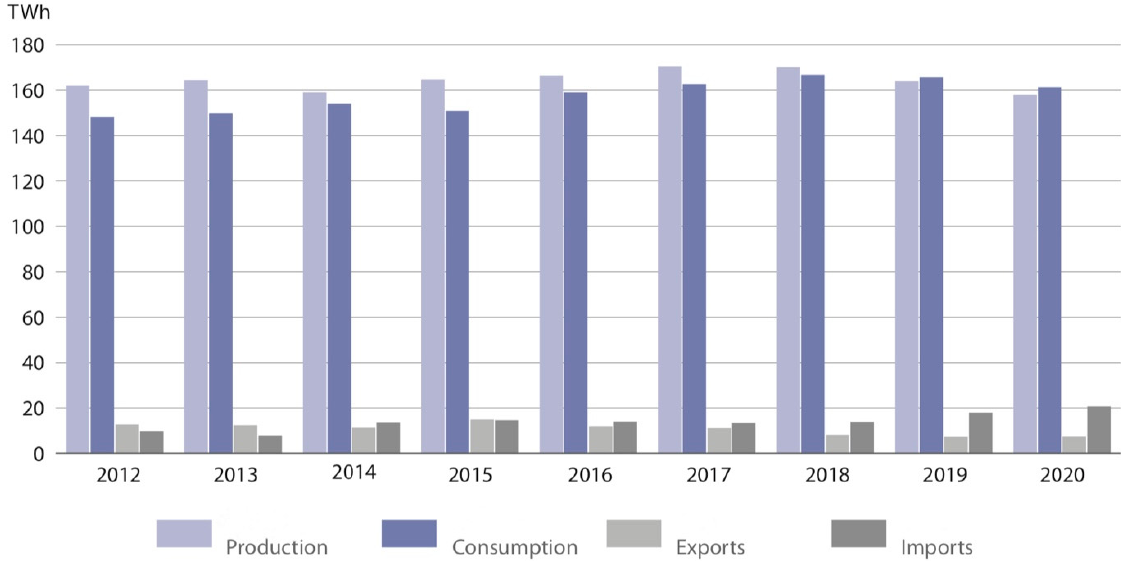
Figure 1. Balance of electricity. Source: authors’ research based on [19].